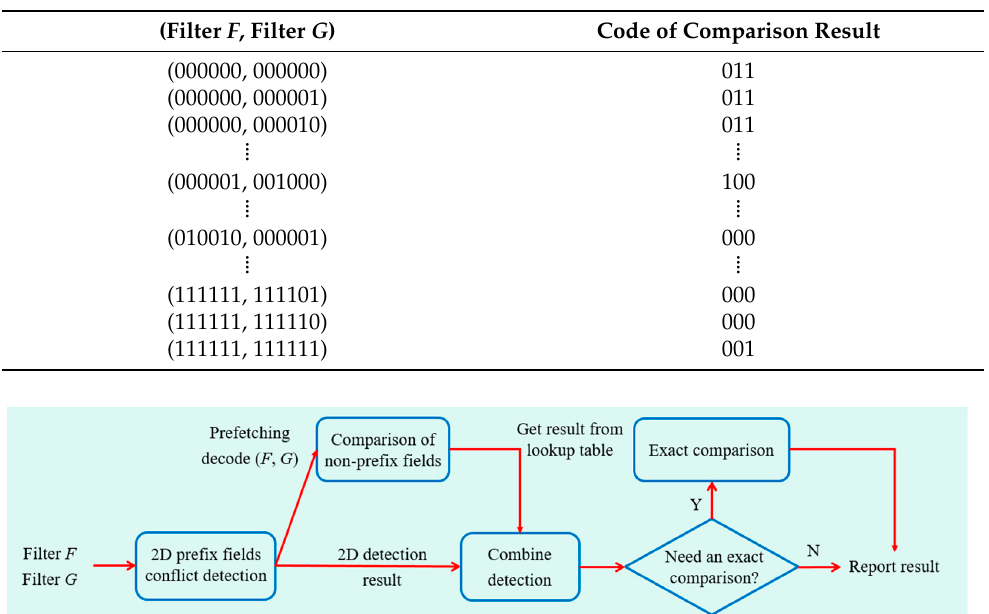
Table 10. The comparison result lookup table.